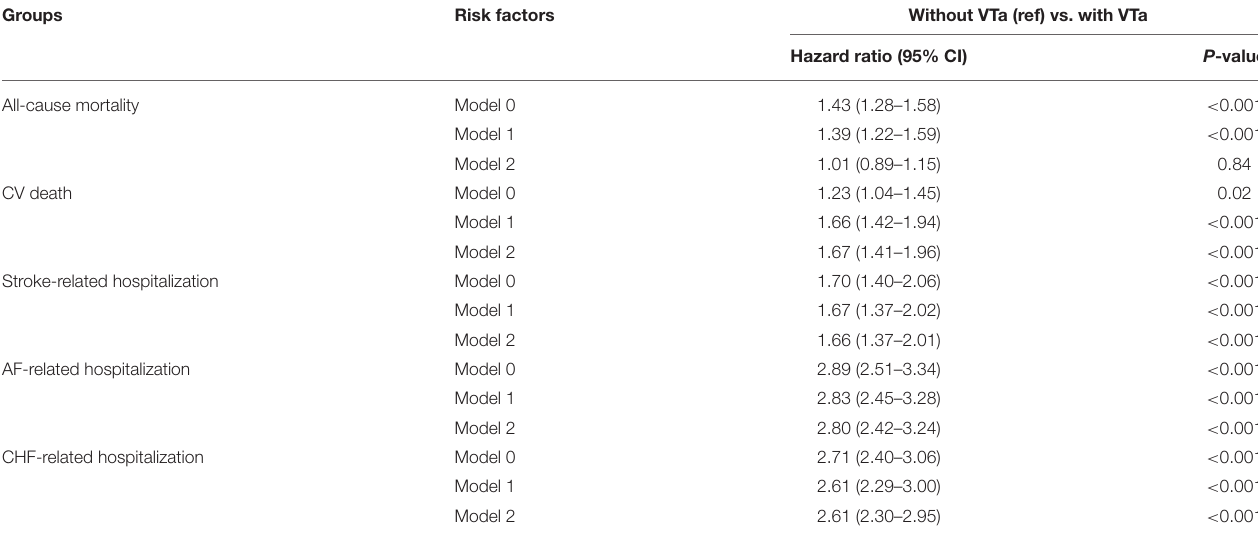
TABLE 5 | Comparison of various outcomes between patients with and without VTa after valve replacement. Groups